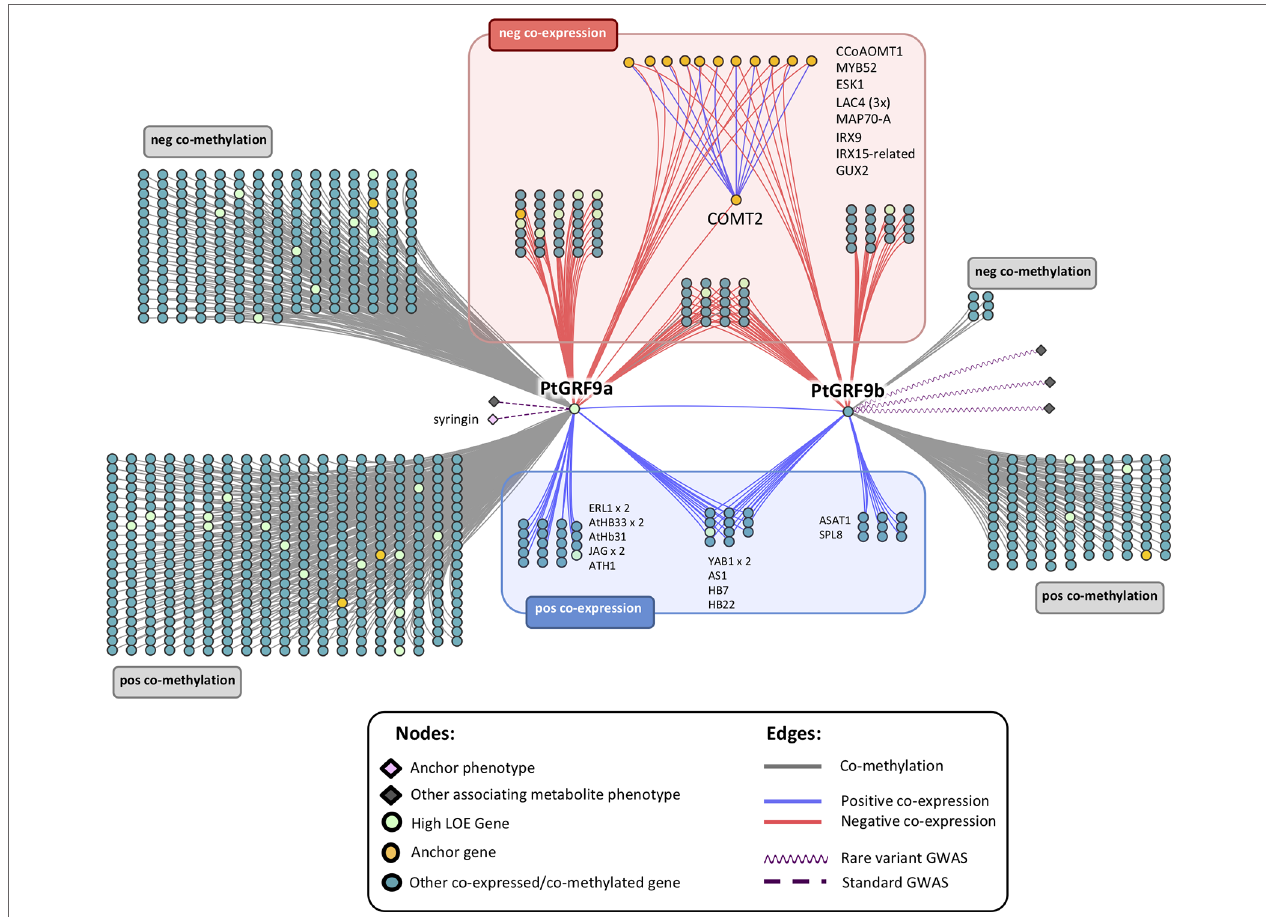
FIGURE 4 | Genome-wide neighborhood of PtGRF9 paralogs in the global input layer networks. Gene symbols are Arabidopsis Best-hit matches. See Supplementary Table S10 for detailed node information; for functional enrichment details, see Supplementary Tables S11 (negatively co-expressed genes) and S12 (positively co-expressed